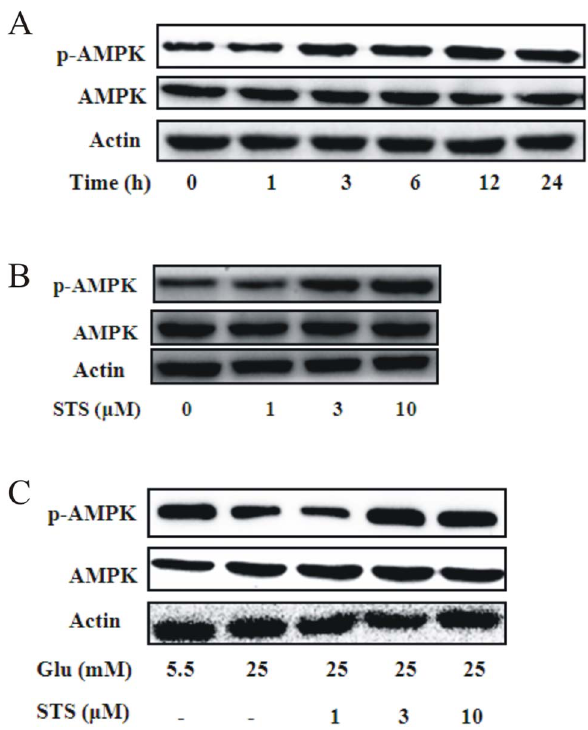
Figure 1. Effect of STS on phosphorylation of AMPK in VSMCs. (A) VSMCs were incubated with 10 m M STS for the indicated times in 5.5 mM glucose (NG). Protein expression of p-AMPK was determined by Western blot analysis. Results are representative of three independent experiments. (B) VSMCs were treated with the indicated concentration of STS for 24 h. Protein expression of p-AMPK was determined using Western blot analysis. Results are representative of three independent experiments. (C) VSMCs were treated with high concentrations of glucose (25 mM, HG) for 24 h in the presence of indicated concentra- tions of STS. Protein expression of p-AMPK was determined using Western blot analysis. Results are representative of three independent